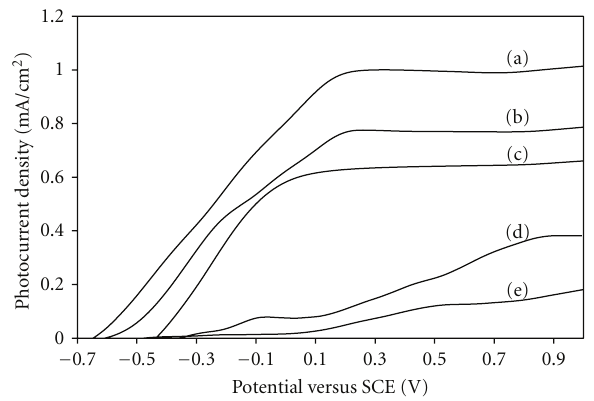
Figure 10: I - V characteristics of TiO 2 nanotubes under light-on condition at (a) room temperature, (b) 40, (c) 60, (d) 10, and (e) 80 ◦ C anodization temperatures.